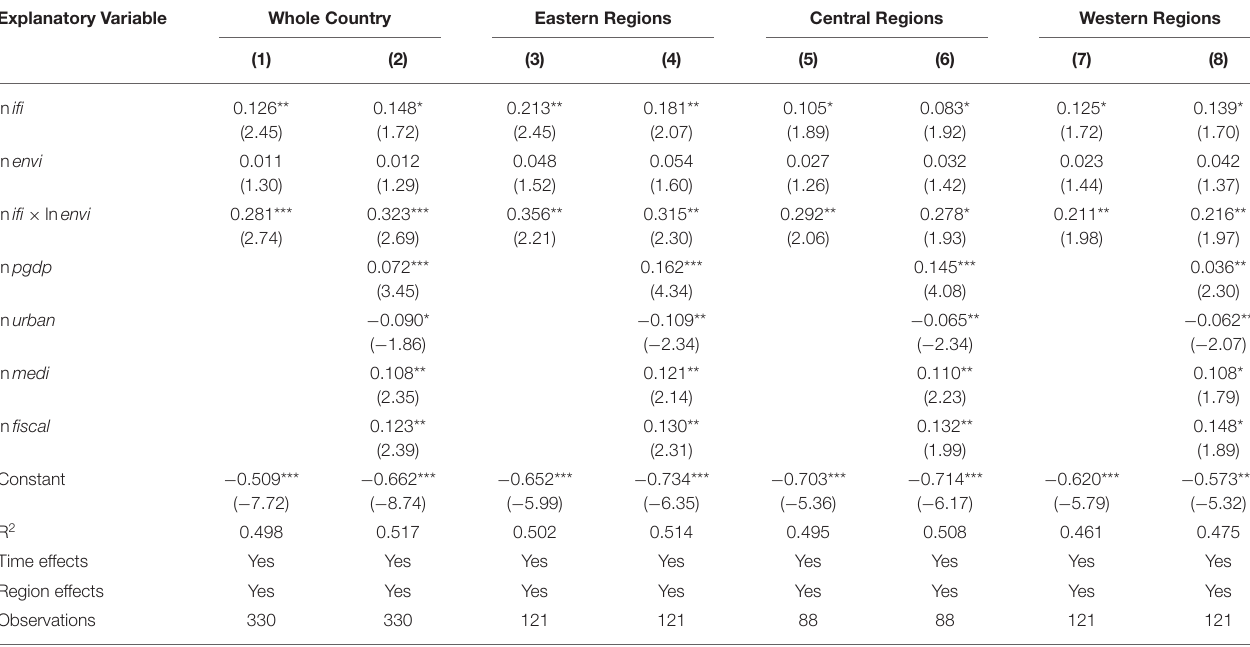
TABLE 3 | Regression results under the effect of environmental